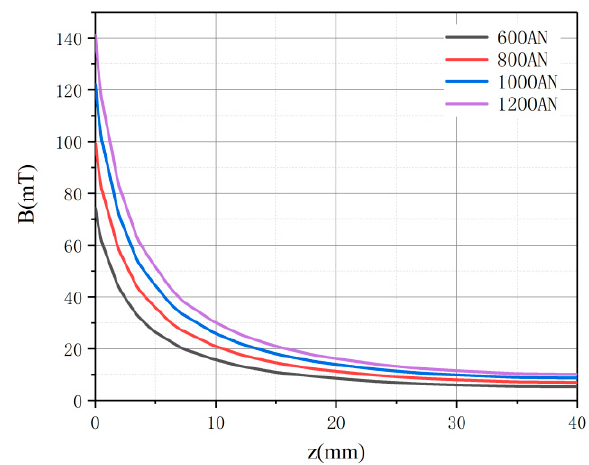
Figure 13. Z-axis magnetic field distribution of the inductive sensor.